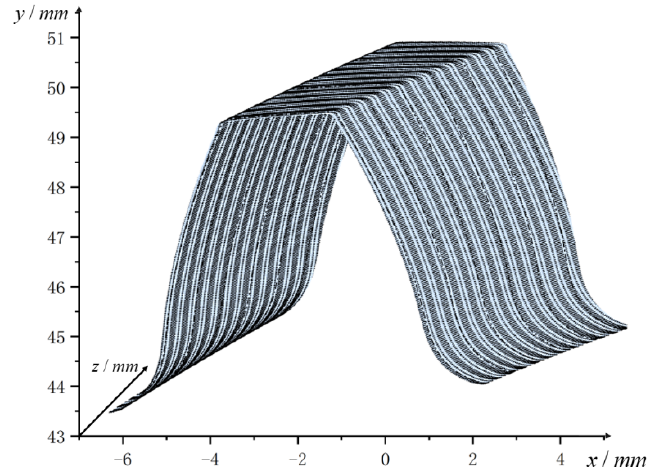
Figure 10. Actual tooth profile surface model.